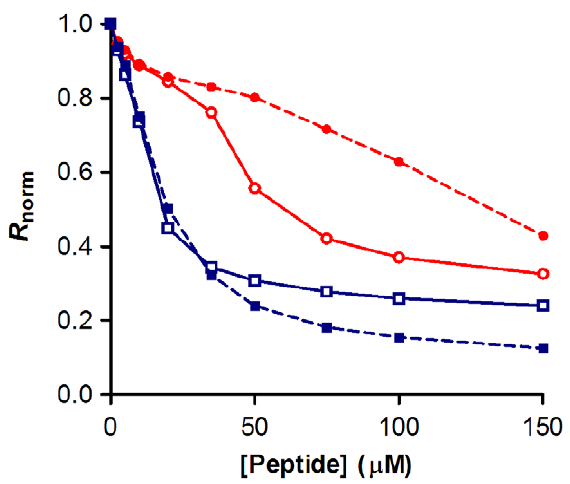
Figure 5. Interaction of the peptides with membrane model systems. The binding profiles for enfuvirtide (red) and T-1249 (blue) were obtained for large unilamellar vesicles composed of POPC (open symbols) and POPC/cholesterol 33% mol (filled symbols).